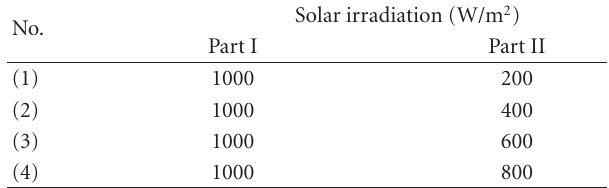
Table 2: Various partial shaded solar